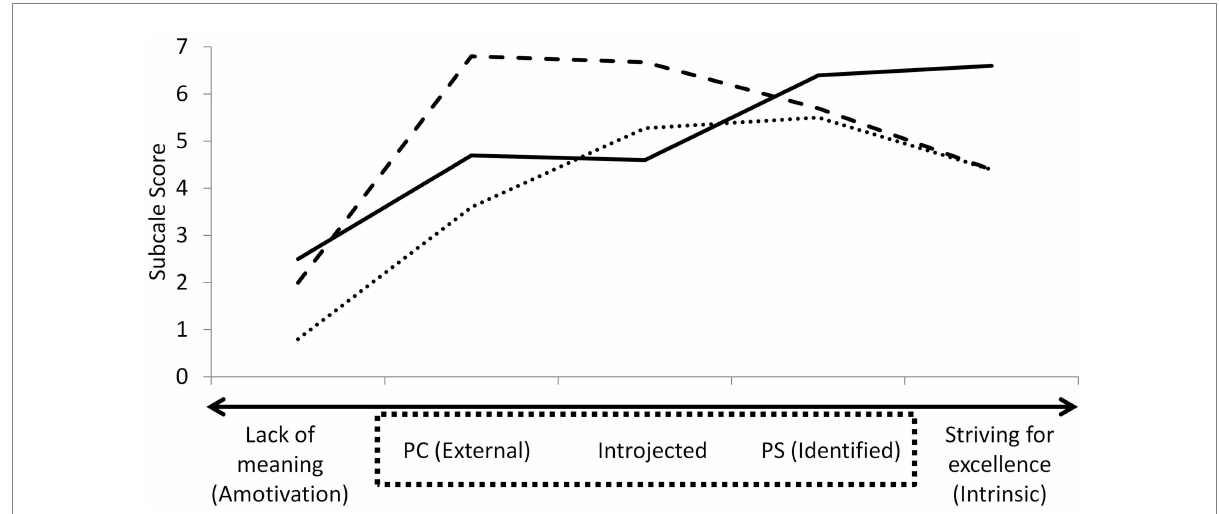
FIGURE 1 Examples of individual profiles for the Multidimensional Perfectionism and Striving for Excellence